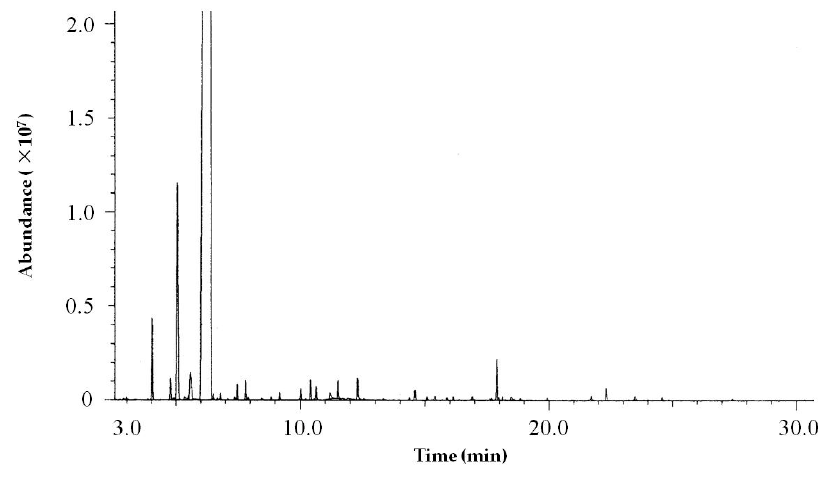
Figure 2. Total ion chromatogram (TIC) of Figure2. Total ion chromatogram (TIC) of GOEO.